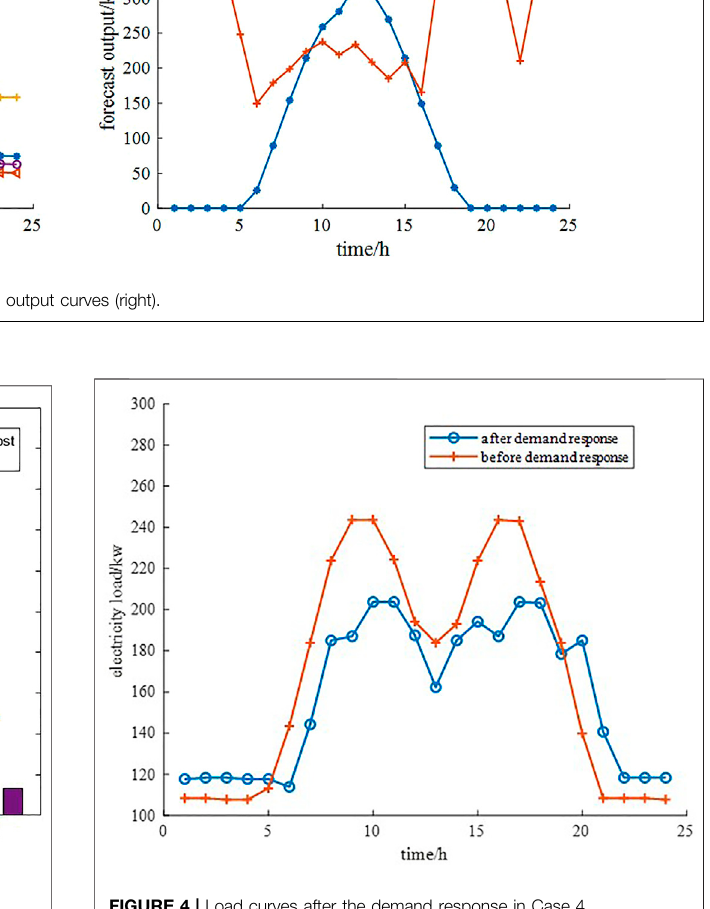
FIGURE 3 | Operation results of the four cases. FIGURE 4 | Load curves after the demand response in Case